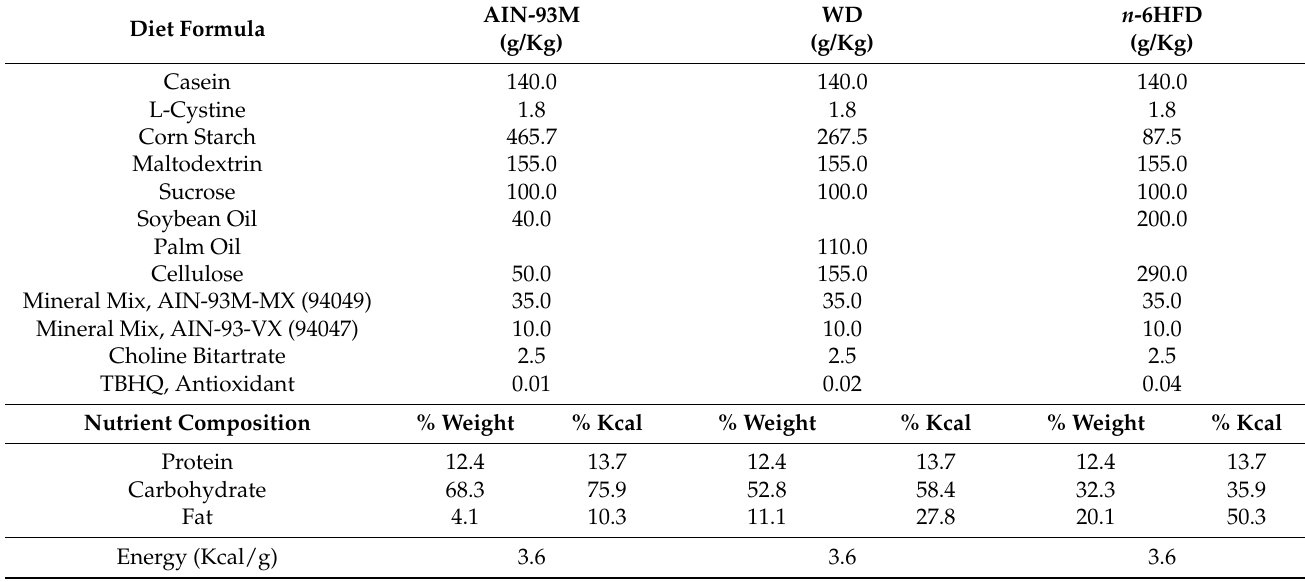
Table 2. Nutrient Composition of Diets a .